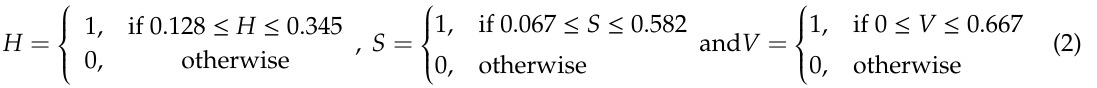
Figure 7. Normalization of ear tag image. Firstly, the input ear tag image is processed using the image preprocessing steps. After we convert the original image into the HSV color space, we threshold the image to focus on the ear tag